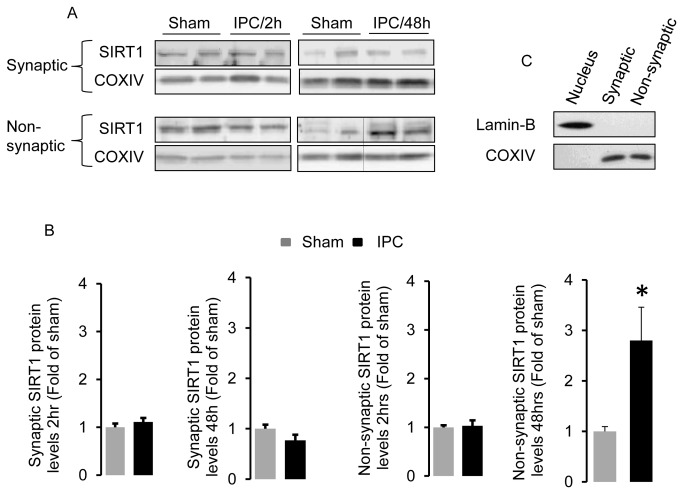
Mitochondrial SIRT1 protein levels increase in the hippocampus following IPC.In (A) a representative Western blot showing SIRT1 protein levels in hippocampal synaptic and non-synaptic mitochondria at 2 and 48 hrs following 2 min of global cerebral ischemia (IPC) from two different animals. Western blot quantitation of synaptic and non-synaptic mitochondrial SIRT1 protein levels is shown in (B) (n = 8). In (C) mitochondrial purity from nuclear contamination was determined by western blot analysis using antibodies to the nuclear localized protein Lamin-B and to the mitochondrial localized protein COXIV. Data are means ± SEM compared to sham treated animals. * p < 0.05 increase from sham by Student’s t-test.